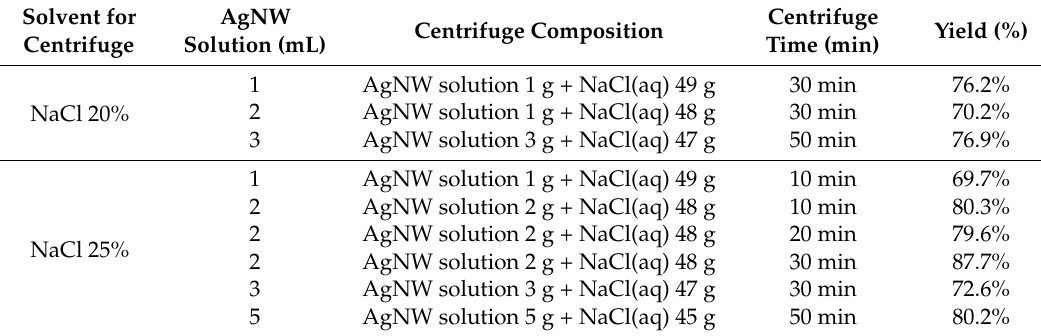
Table 4. Recovery of AgNWs from AgNW/EG reaction mixture with centrifuge condition. Solvent for